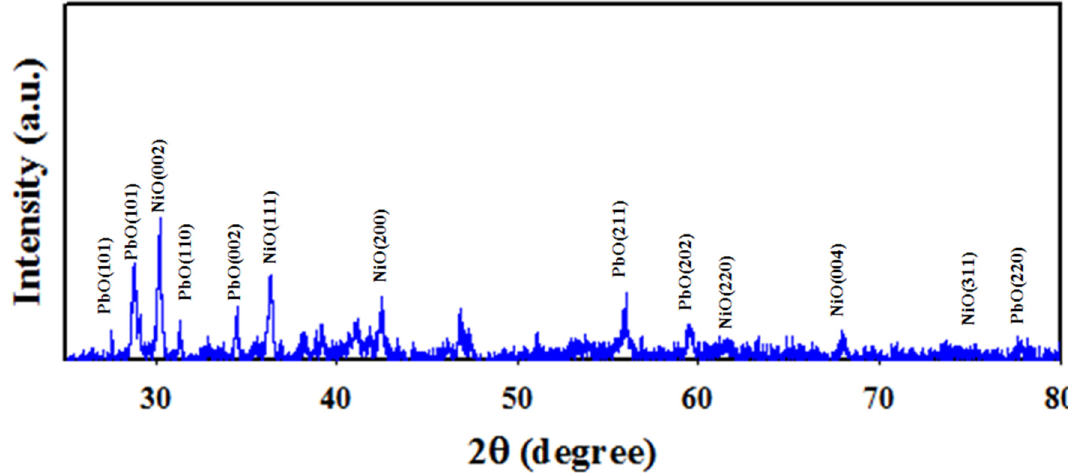
Figure 3. XRD analysis of PbO-doped NiO NCs performed at 2 θ = 20–80°.